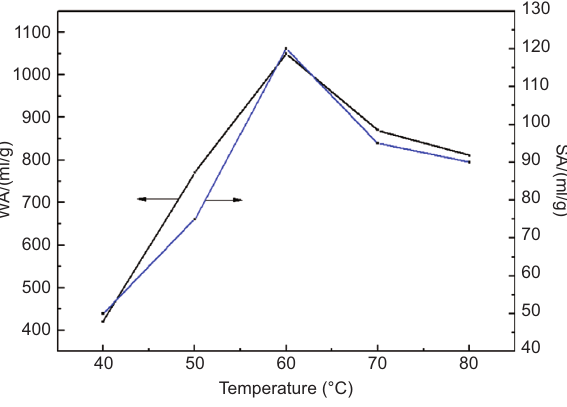
Figure 1 The effect of temperature on the WA and SA of